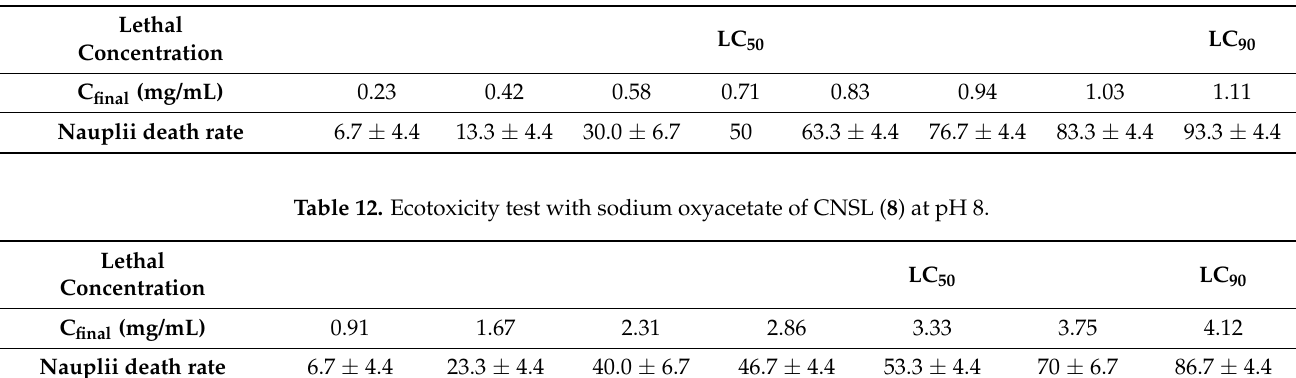
Table 11. Ecotoxicity test with SDS at pH 8.